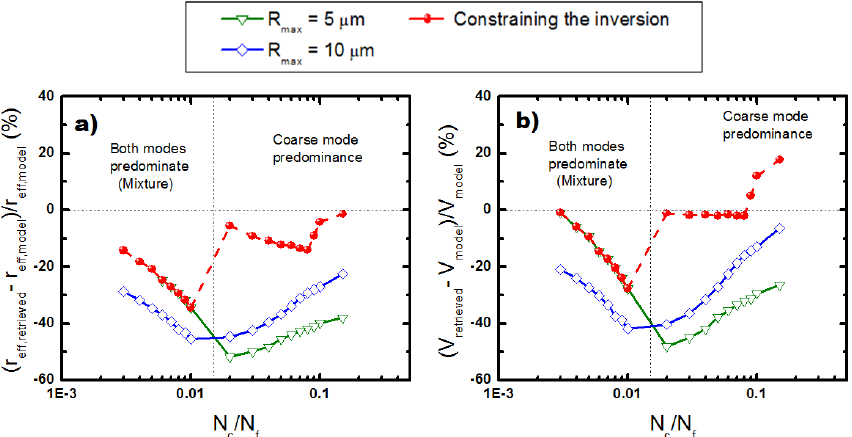
Figure 4. (a) Relative difference in the effective radius and (b) in columnar volume aerosol content vs. the fraction between coarse and fine number of particles ( N c /N f ) . Data correspond to Scenario II.